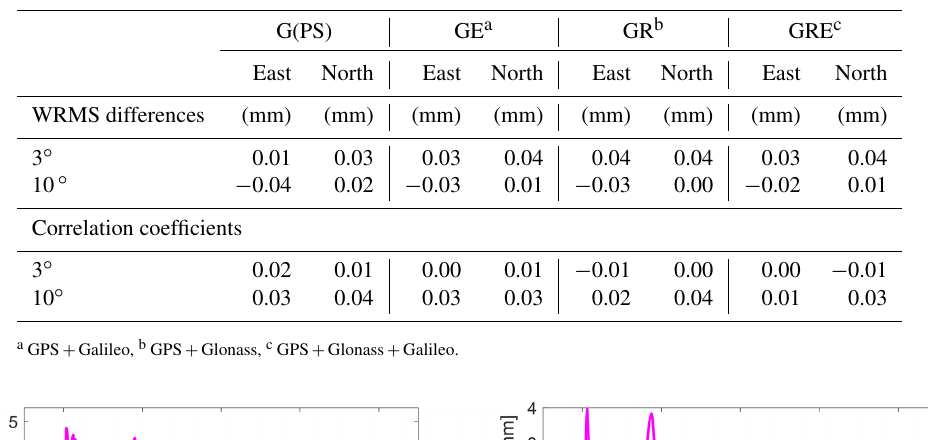
Table 4. The changes in WRMS differences and correlations of east and north gradients when a weaker constraint is applied in the GNSS data processing. The changes are the results from the constraint of 1.0mm